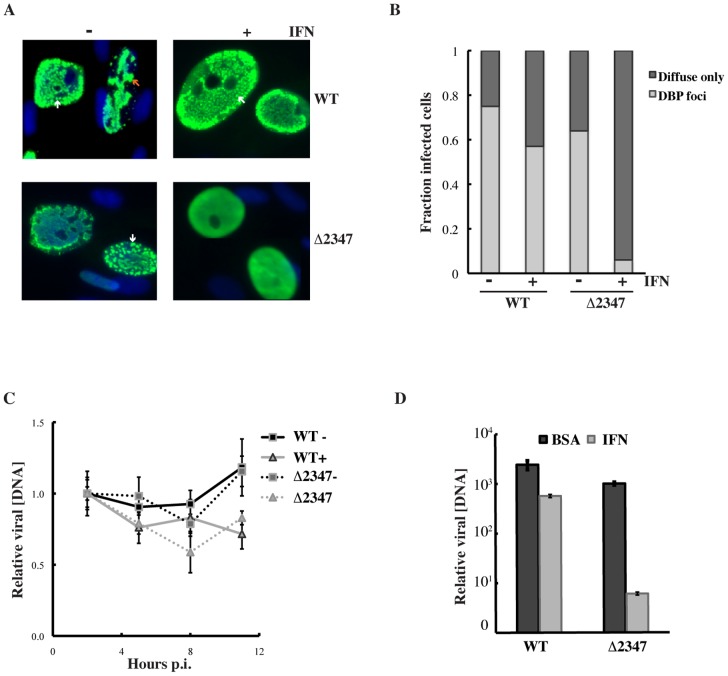
The E1B 55 kDa protein prevents inhibition of formation of viral replication centers in IFN-treated cells.(A) HFFs untreated or treated with IFN as indicted were infected with 30 p.f.u./cell AdEasyE1 (WT) or AdEasyE1Δ2347 (Δ2347), and the E2 DBP (green) examined by immunofluorescence as described in Materials and Methods. Nuclei were stained with DAP1 (blue). The white and orange arrows indicate discrete DBP foci, and larger structures, respectively. (B) The numbers of infected cells exhibiting replication centers or only diffuse nuclear DBP staining (light and dark gray bars, respectively) respectively were counted, and are represented as the fraction of the total number of infected cells (n = 161 and 151, WT - and +IFN respectively, and 151 for Δ2347 both – and +IFN). (C and D) IFN treated (+) and untreated (−) NHBECs were infected with 5 p.f.u./cell AdEasyE1(WT) or AdEasyE1Δ2347 (Δ2347) and nuclear concentrations determined at the early (C) and later (D) times after infection indicated. Values were corrected using the concentrations of β-actin internal control DNA, and normalized relative to the input concentrations at 2 hrs. p. i. The averages and standard deviations calculated as described in Materials and Methods of two independent experiments are shown.